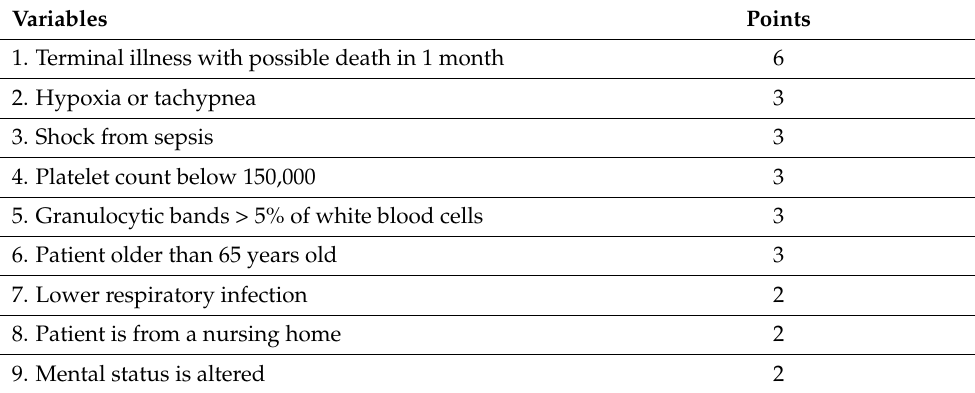
Table 8. Variables and points of the Mortality in Emergency Department Sepsis (MEDS)